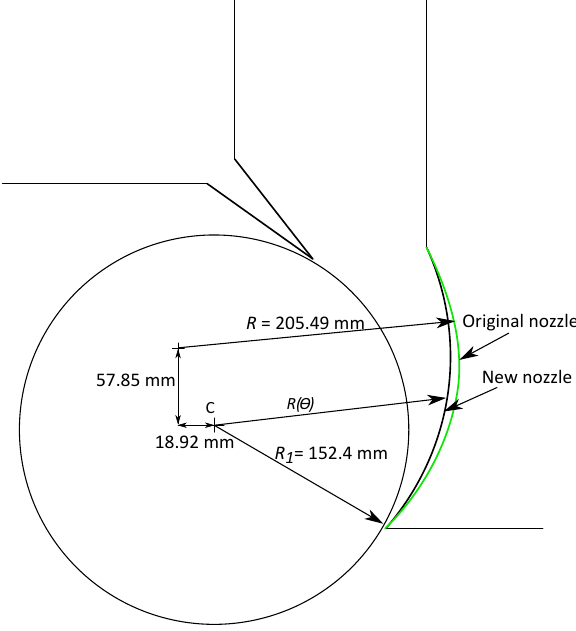
Figure 9. The original and new nozzle design for the 0.53 kW turbine. Table 3. Influence of blade number on the efficiency of 0.53 kW turbine